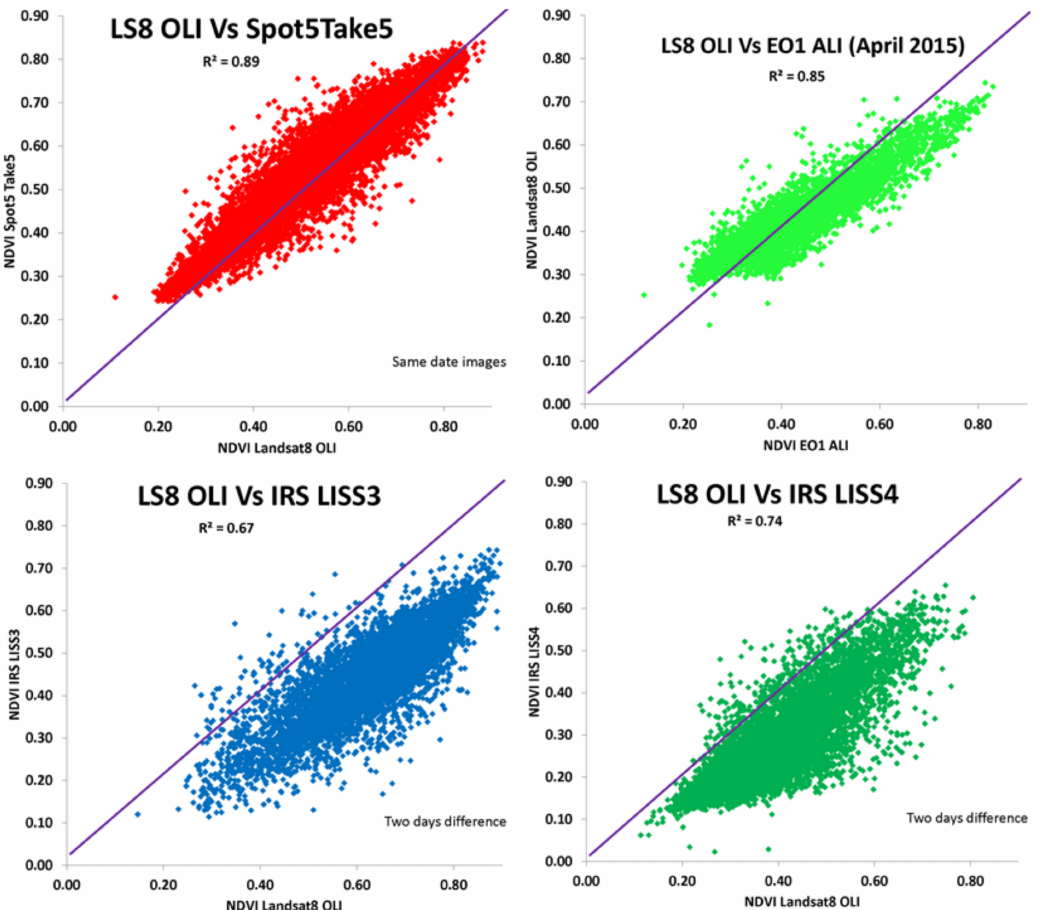
Figure 6. Linear relation between Landsat-8 (LS8) Operational Land Imager (OLI) NDVI and other satellites’ corrected NDVI. The linear regression equations were applied to the NDVI datasets derived from the other satellite images (EO1 (ALI); Spot5Take5; IRS-P6 (LISS3); IRS-P6 (LISS4)). Equations (1)–(4) represent the equations obtained from linear regression between NDVI values obtained from Landsat-8 (OLI) and other satellite datasets. These equations were further implemented over other satellite datasets to calculate refined NDVI